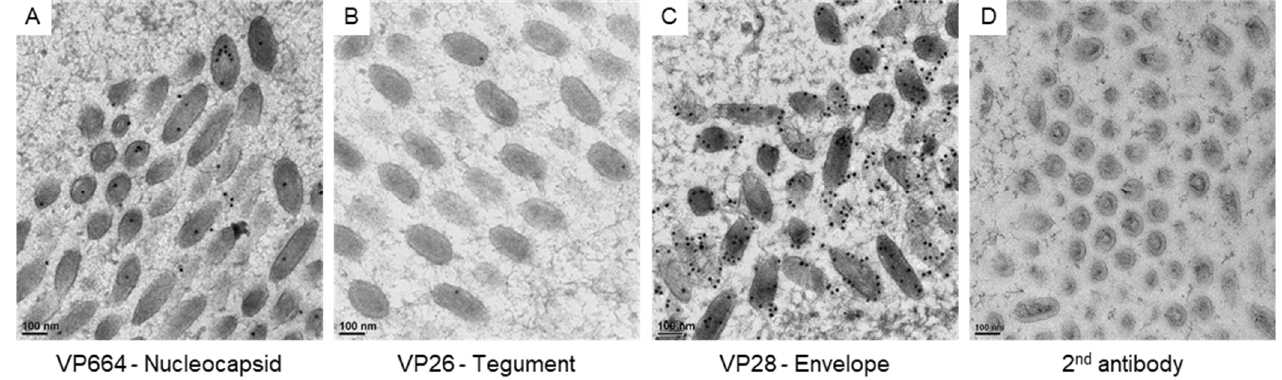
Figure 4. The expressions of viral proteins on matured WSSV particles. The represented images show the immuno-gold labeling of the nucleocapsid protein VP664 ( A ), the tegument protein VP26 ( B ), and the envelope protein VP28 ( C ) on matured WSSV particles. ( D ): the negative control without the incubation of primary antibodies.